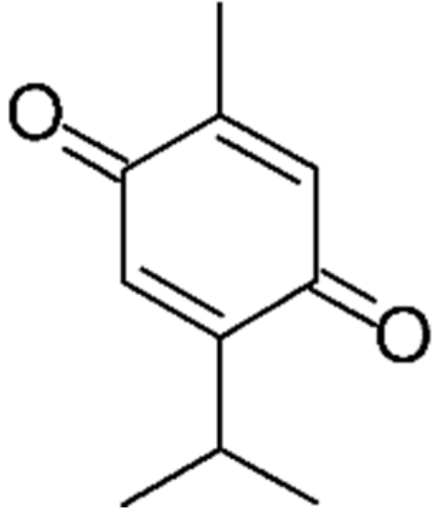
Figure 1. Chemical structure of thymoquinone.